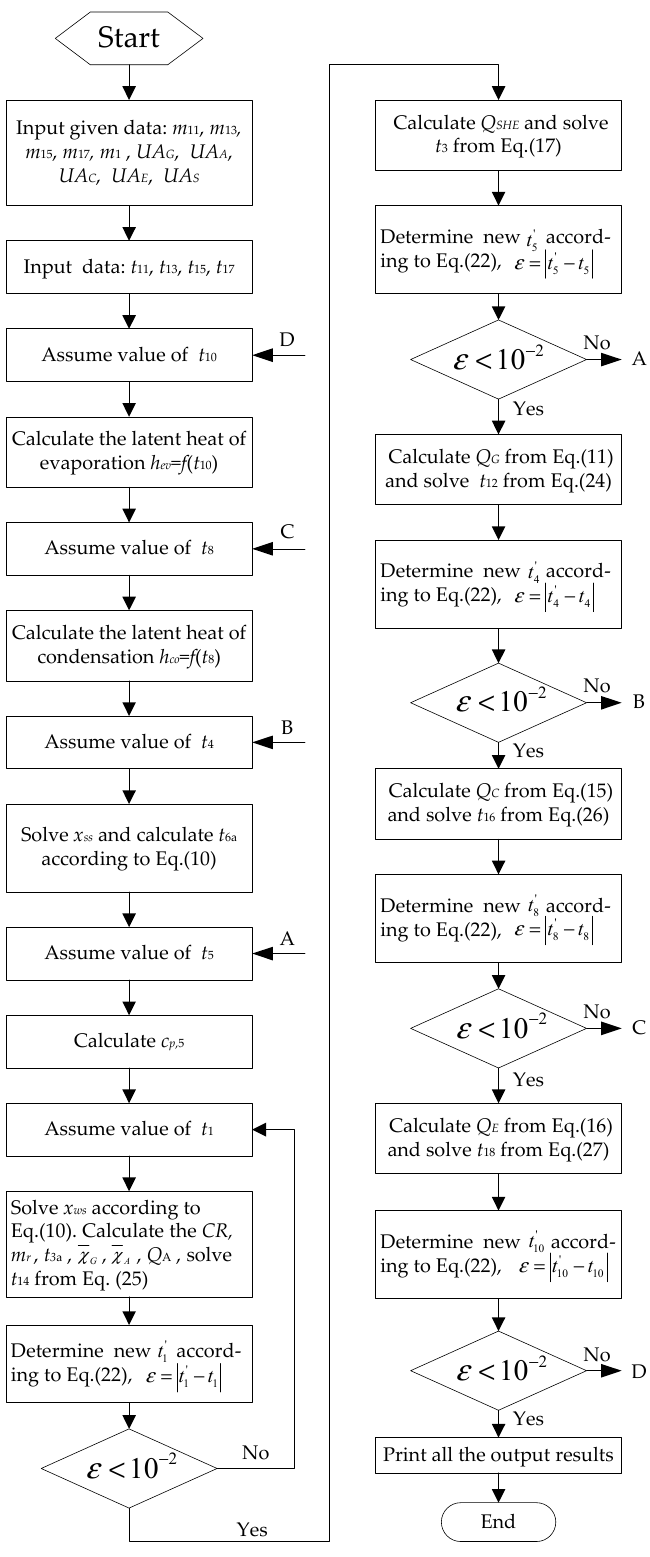
Figure 2. Flow chart of the calculation procedure.